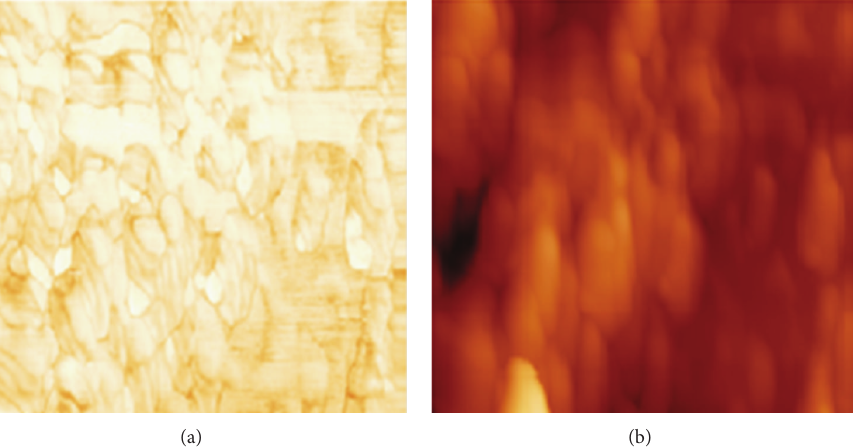
Figure 2: Atomic force microscopy. Images of nanoparticles. (a) Nanoparticles formed by chitosan/plasmid with the size of 100–150 nm. (b) Nanoparticles formed by chitosan/plasmid/magnetic nanoparticle with the size of 200–250